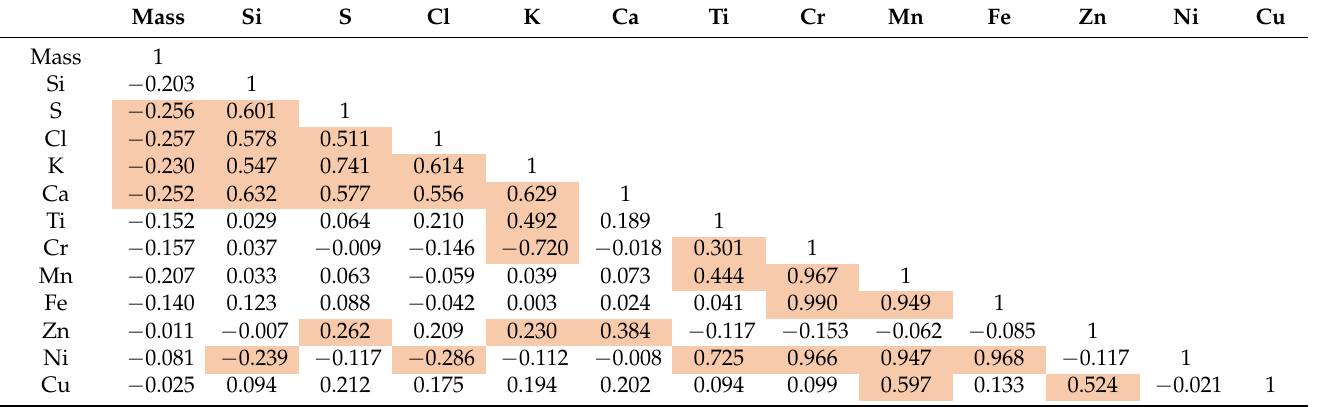
Shaded correlation coefficients are statistically significant at p <